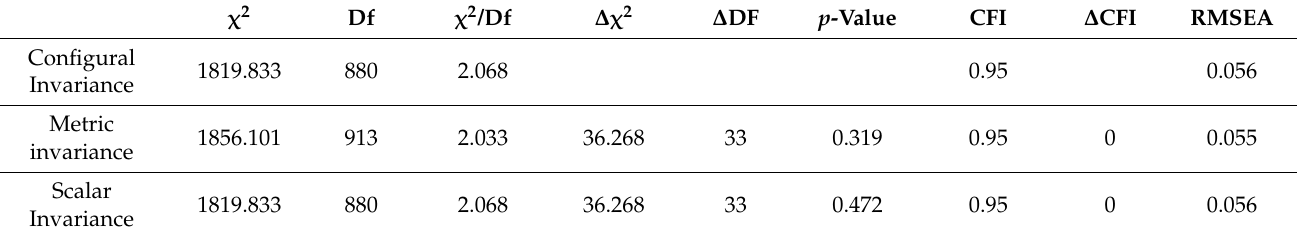
Table 7. Model Fits for Invariant Test across Gender Training in the Specific